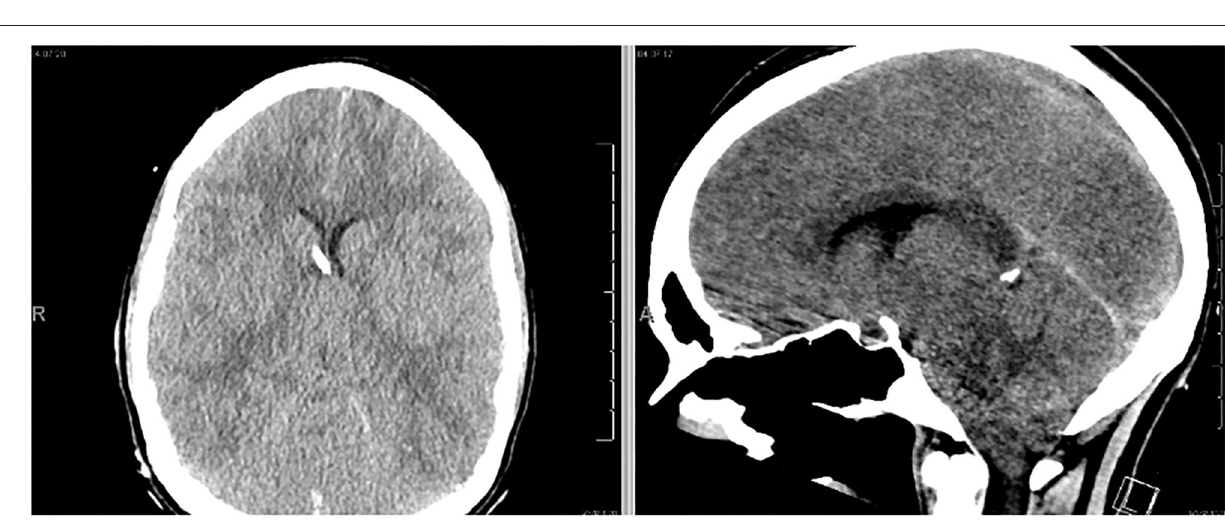
FIGURE 2 | The patient exhibited anisocoria and severe headache following hospital admission. Follow-up CT scan demonstrated profound cerebral edema and downward tonsillar herniation. An EVD was successfully placed (left